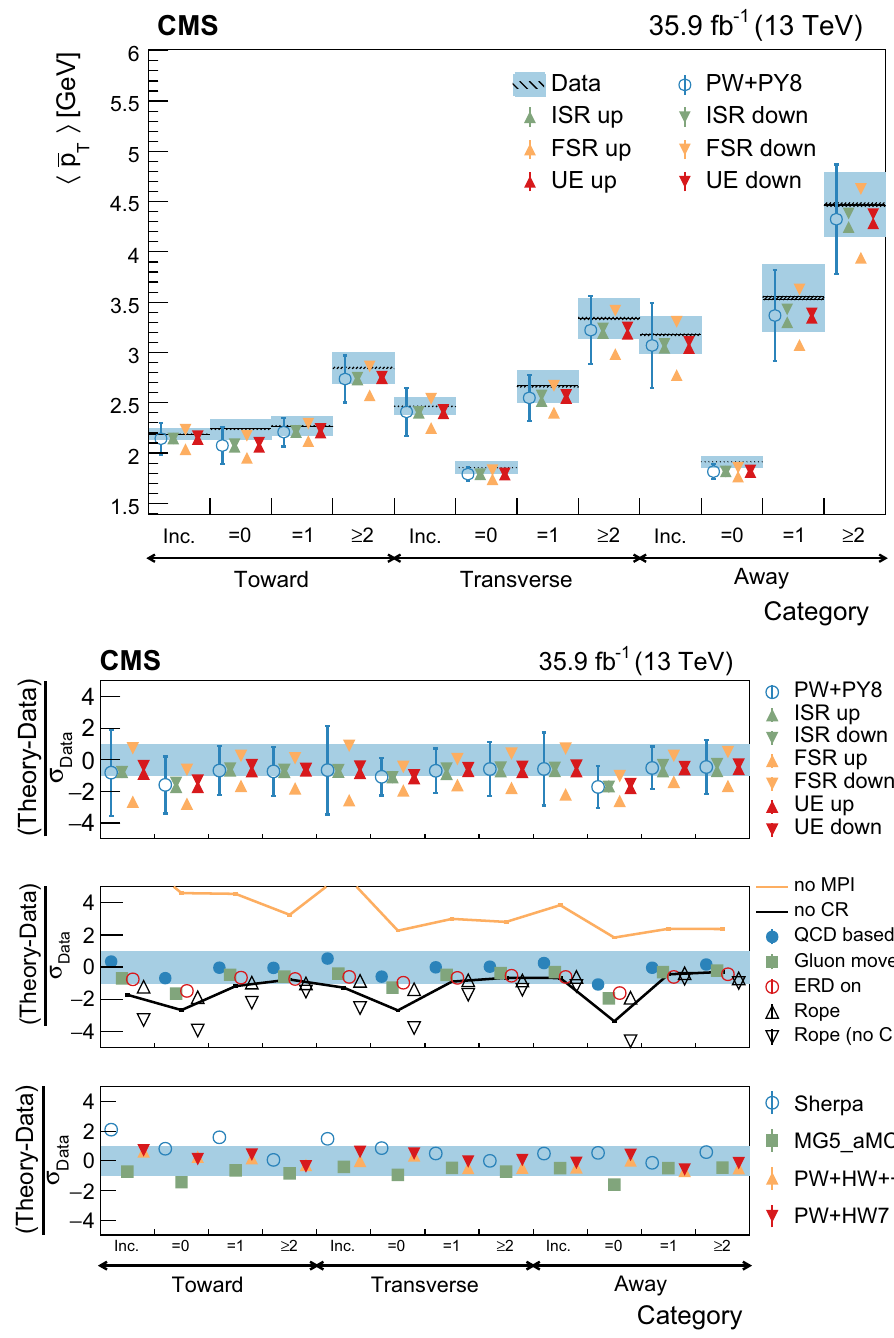
Fig. 25 Average p T in different jet multiplicity categories. The conventions of Fig. 14 are